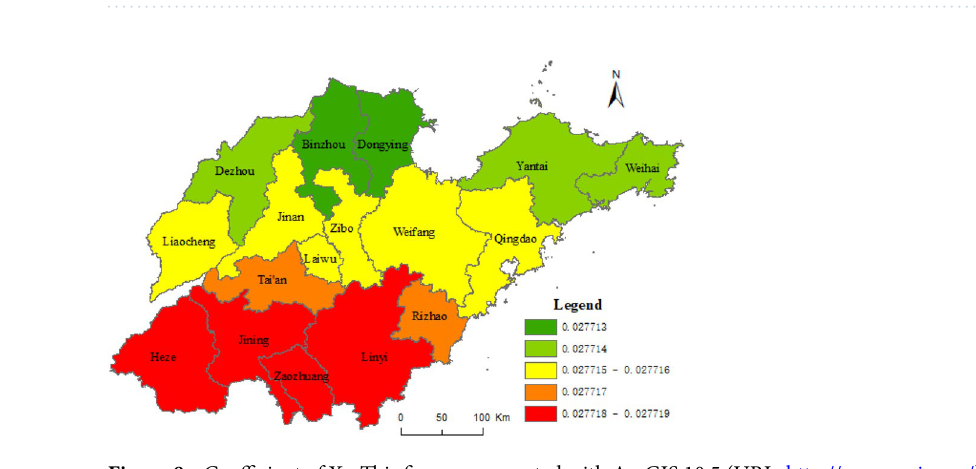
Figure 8. Coefficient of X 8 . This figure was created with ArcGIS 10.5 (URL: http:// www. esri.